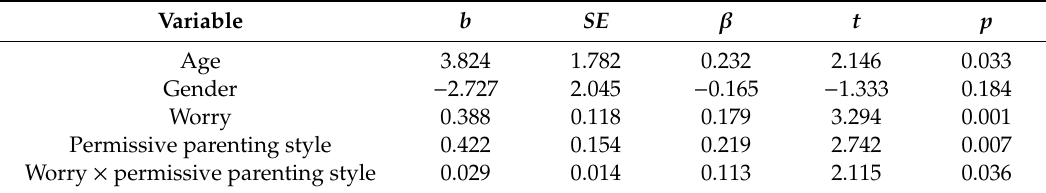
Table 2. The moderating e ff ect of the permissive parenting style on the relationship between worry and Internet addiction. and Internet addiction.